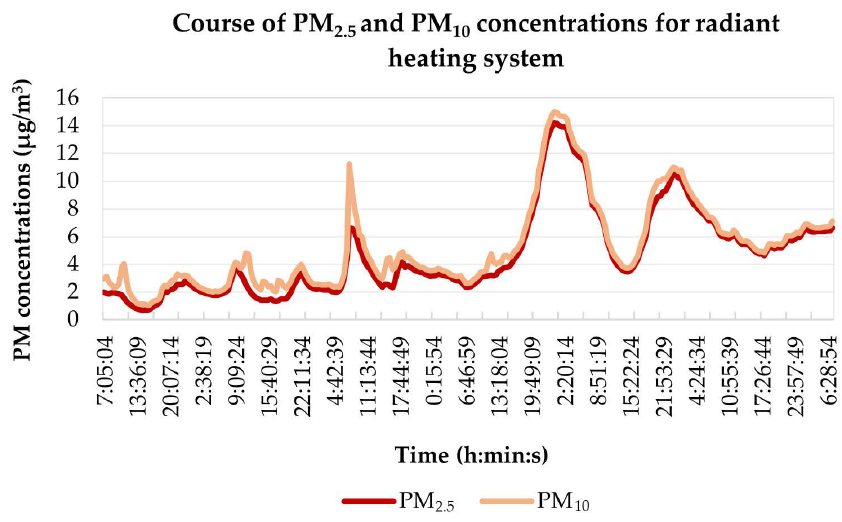
Figure 12. Courses of PM 2.5 and PM 10 concentrations for RHS.